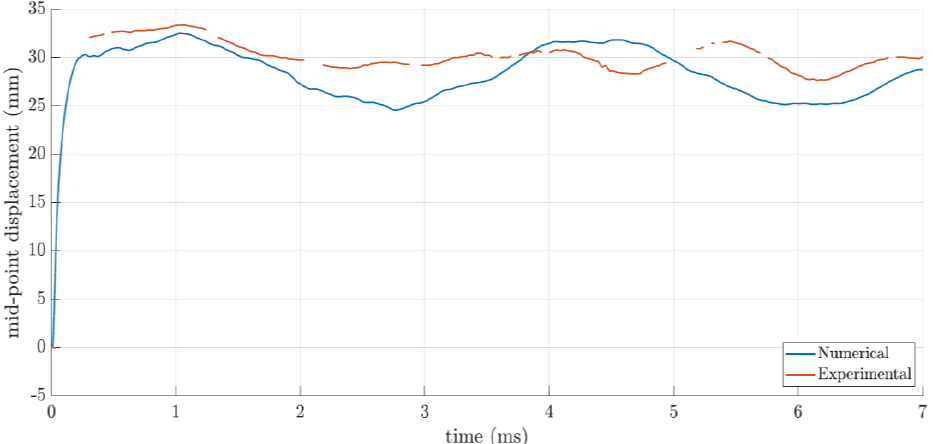
Figure 18. Graph of transient midpoint displacement versus time for a 105° V-structure with a 32 mm tip radius subjected to a 20 g detonation, comparing experimental and simulated data.